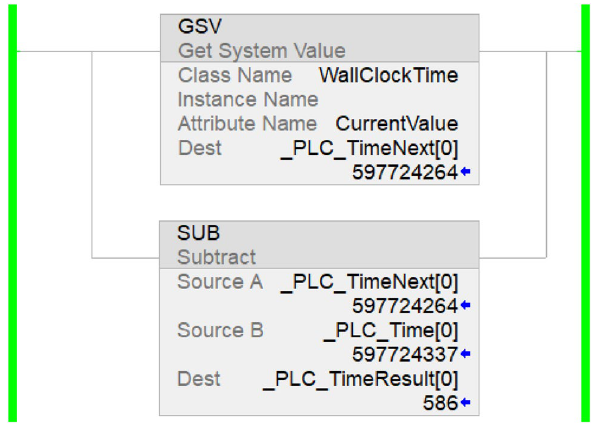
Fig. 14 Capturing the scan time by the end of the